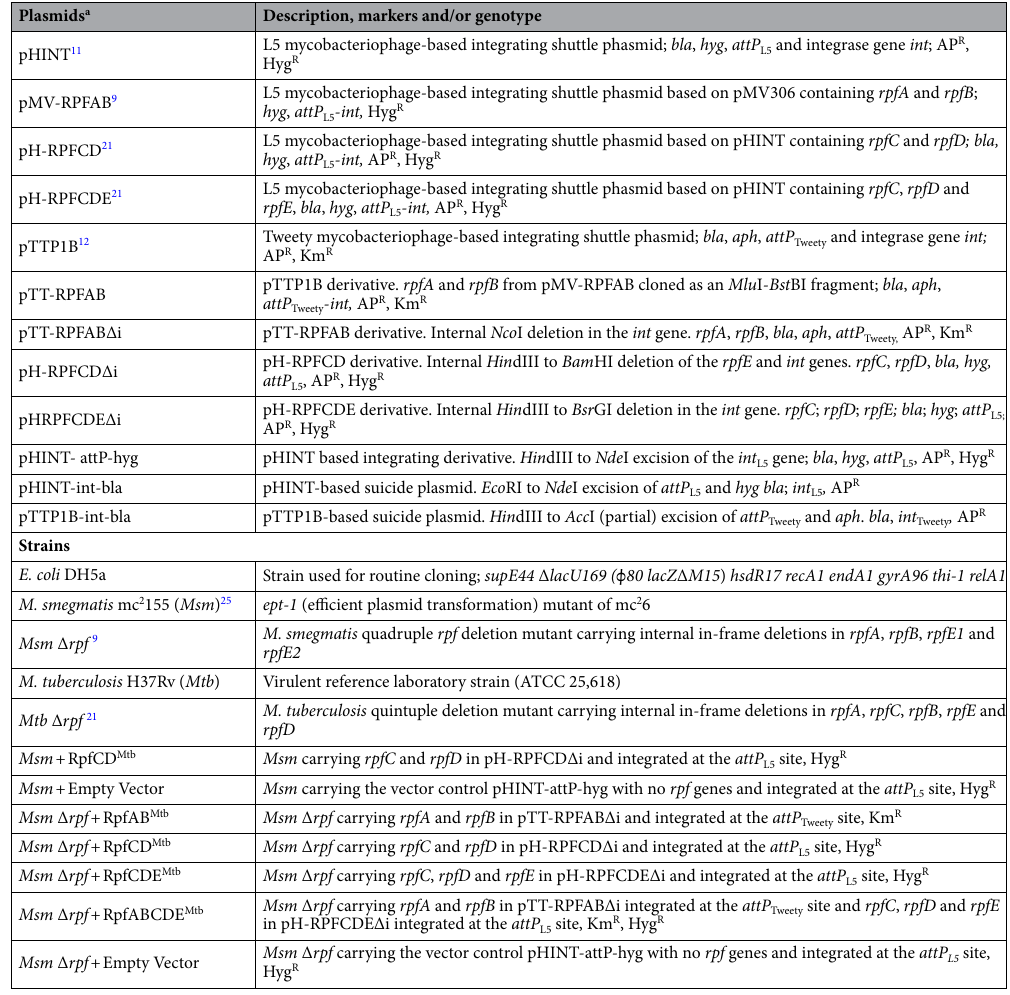
Table 2. Plasmids and strains used in this study. Ap R ampicillin-resistant, Hyg R hygromycin-resistant, Km R kanamycin-resistant. a Where relevant, the reference for the plasmid/strain is given. In other cases, the plasmid/ strain originated from laboratory stocks or this